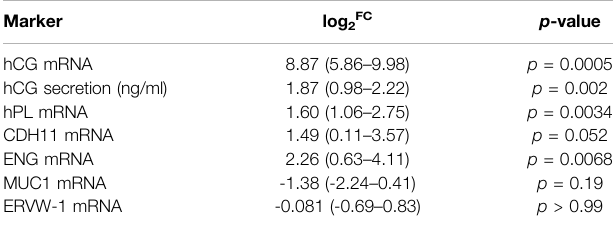
TABLE 2 | Evaluation of mRNA expression and protein secretion of commonly used syncytialization markers.